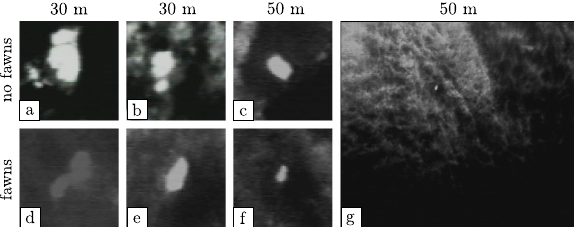
Figure 9: thermal image cut-outs of typical hot spots at a flight altitude of 30 and 50